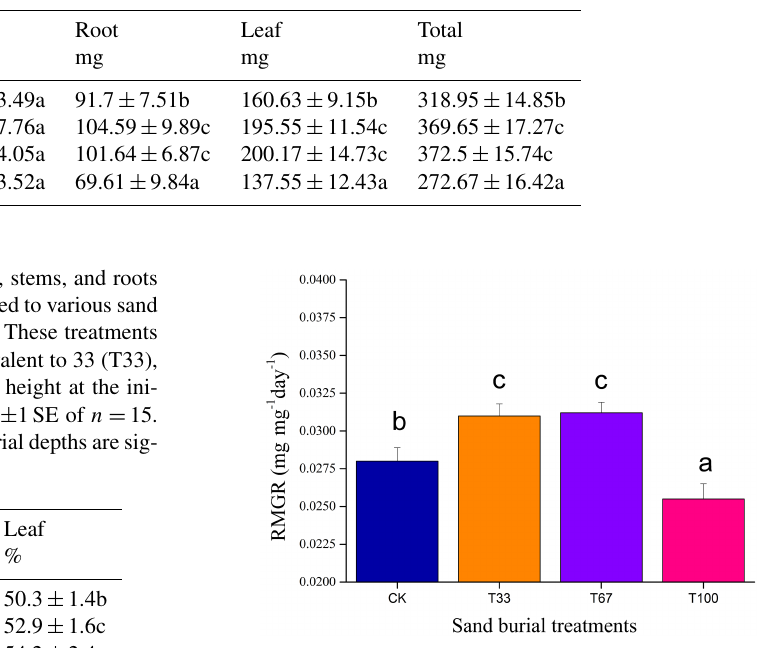
Figure 4. Relative mass growth rate (RMGR) on seedlings of Ulmus pumila var. sabulosa exposed to various sand burial treatments dur- ing a 45-day growth period. These treatments included sand burial of seedlings to a depth equivalent to 33 (T33), 67 (T67), or 100% (T100) of the mean seedling height at the initiation of the study. Each histogram is the mean ± 1SE of n = 15. Different letters above histograms among seed burial depths are significantly different at P